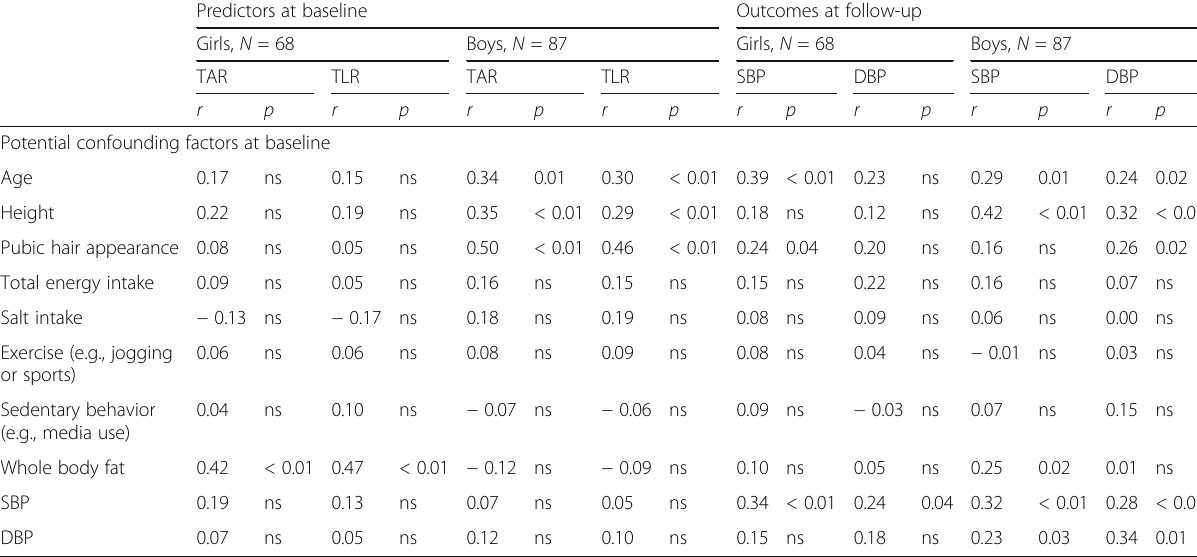
Table 4 Potential confounding variables which may affect relationships between predictors and outcomes Predictors at baseline Outcomes at follow-up Girls, N = 68 Boys, N = 87